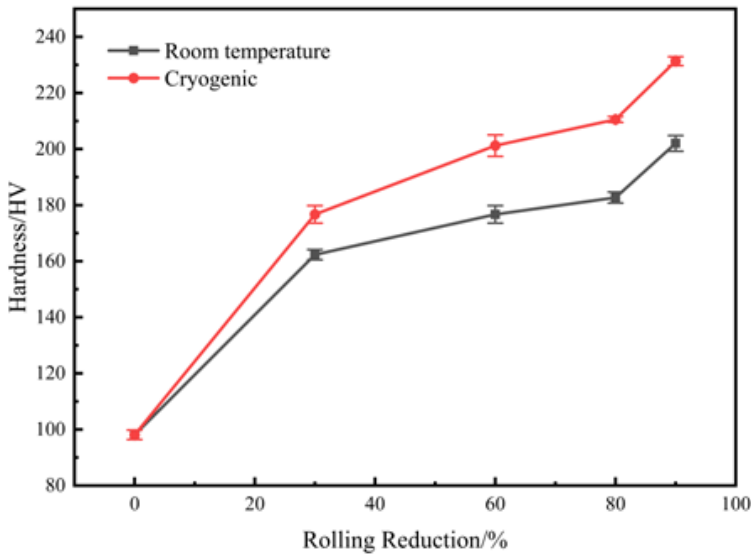
Figure 3. The variations of hardness with different rolling reductions.